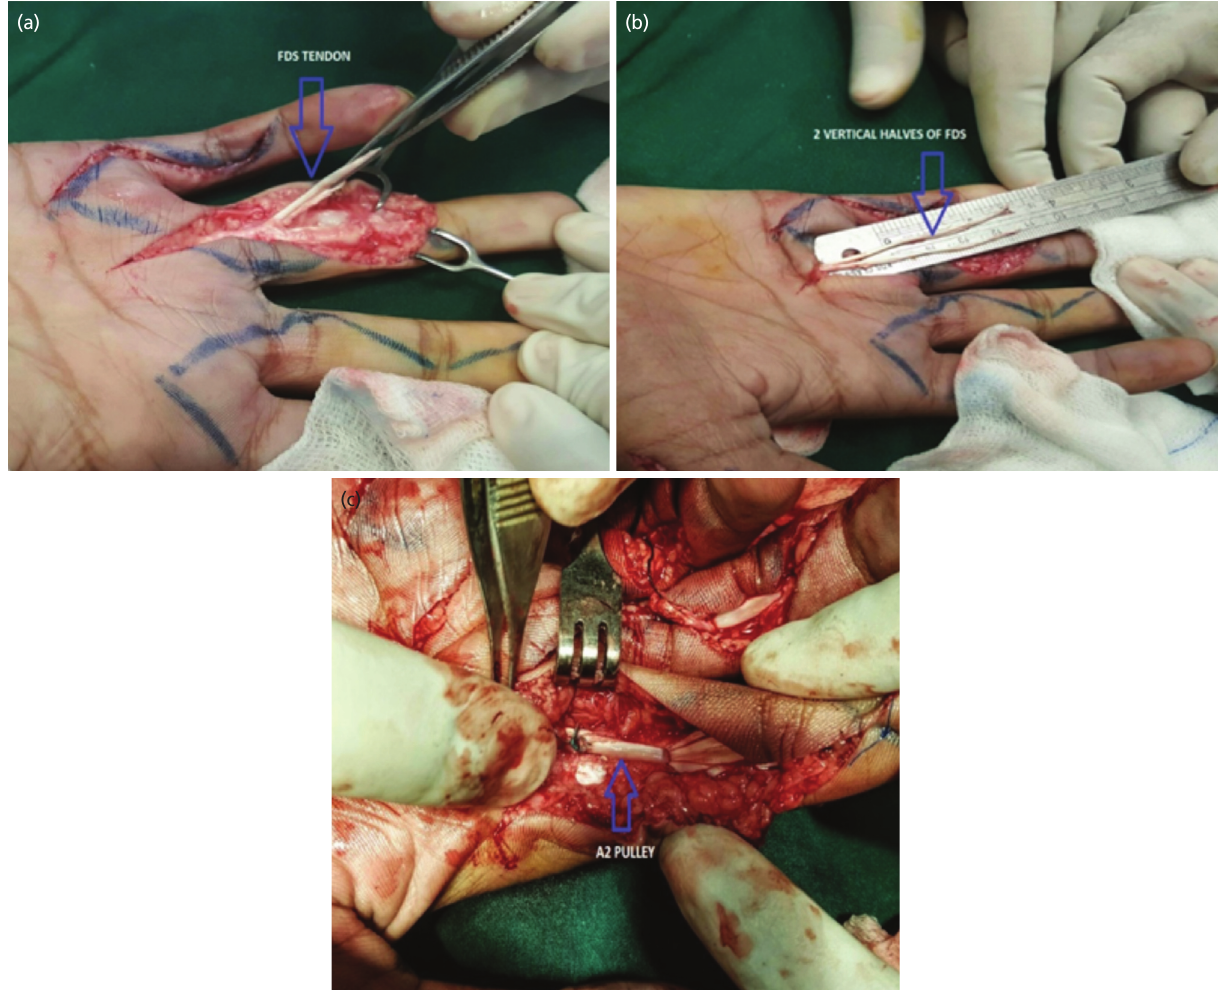
Fig. 2 (a) Exploration of FDS tendon, (b) splitting of each slip of FDS tendon into two vertical halves, (c) tendon looped to